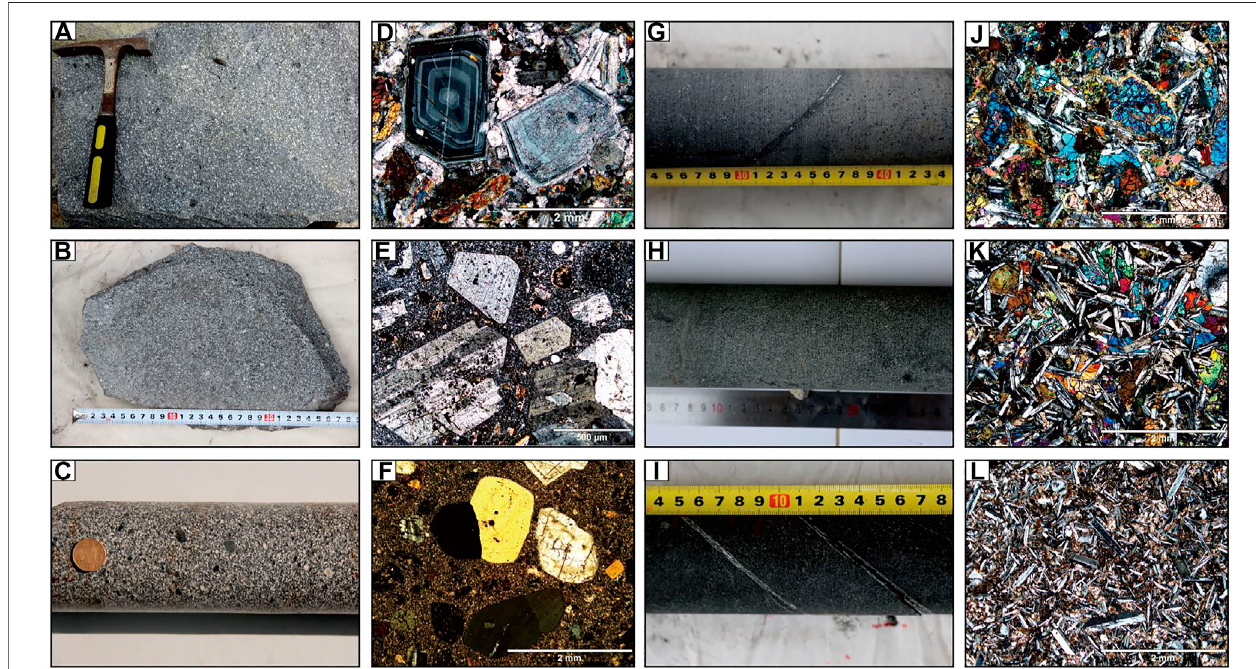
FIGURE 2 | Hand-specimen and thin-section microscopic photos of subvolcanic rocks from the Huaibei-Linhuan coal fi eld: (A) Taiping (TP-01) diorite; (B) Haizi (HZ-08)diorite; (C) Yangliu (YL-03) diorite; (D) Taiping granodiorite with feldspar phenocrysts; (E) Haiziporphyriticdiorite with altered euhedral feldspar phenocrysts; (F) Yangliu granodiorite porphyry with quartz and plagioclase phenocrysts; (G) Qingdong (TT-07) microgabbro; (H) Yuandian-1 (Y1-29) dolerite; (I) Yuandian-2 (Y2-23) dolerite; (J) Pyroxene and plagioclase in the Qingdong microgabbro (XPL); (K) Plagioclase and pyroxene in the ophitic-textured Yuandian-1 dolerite (XPL); (L) Plagioclase and fi ne-grained Fe-Ti oxides in the Yuandian-2 dolerite (XPL).